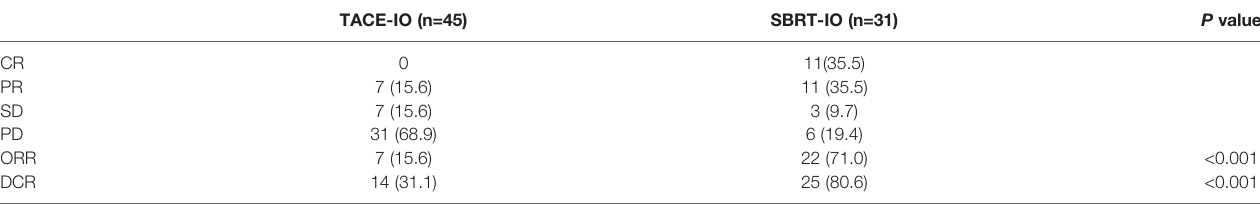
TABLE 3 | Best tumour